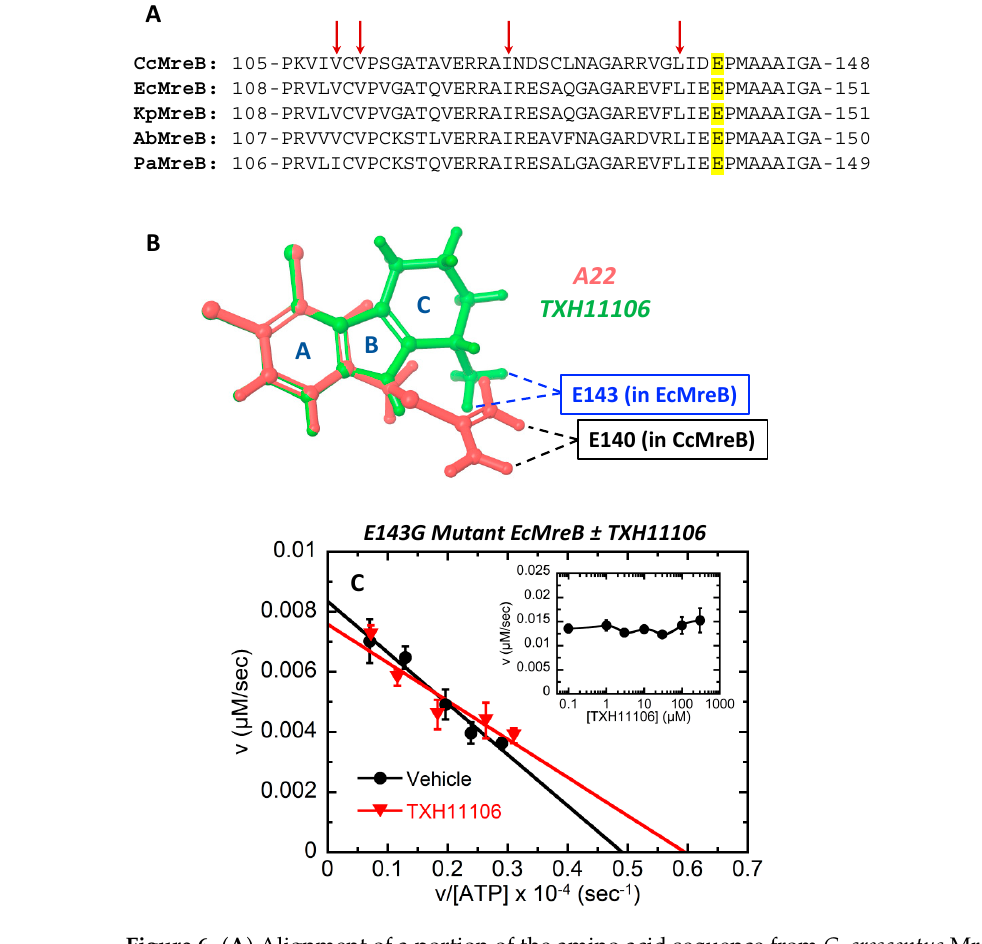
Figure 6. ( A ) Alignment of a portion of the amino acid sequence from C. crescentus MreB (CcMreB), E. coli MreB (EcMreB), K. pneumoniae MreB (KpMreB), A. baumannii MreB (AbMreB), and P. aeruginosa MreB (PaMreB). As revealed by the previously reported crystal structure of the CcMreB-A22 complex (PDB: 4CZG) [23], this portion of the MreB amino acid sequence includes residues that form key contacts with the inhibitor. The E140 residue in CcMreB (highlighted in yellow) that forms electrostatic and hydrogen bonding contacts with the amidine functionality of A22 is conserved in the EcMreB, KpMreB, AbMreB, and PaMreB proteins. The hydrophobic residues of CcMreB (indicated by the arrows) that form Van der Waals contacts with ring A of A22 are also conserved in the other four MreB proteins. ( B ) Overlay of the gas-phase models of A22 (red) and TXH11106 (green). The contacts observed between the E140 residue of CcMreB and the amidine substituent of A22 are depicted by the black dashed lines, with the proposed corresponding contacts between the E143 residue of EcMreB and the amino functionality on ring C of TXH11106 being depicted by the blue dashed lines. The gas-phase models were generated using the Jaguar application of the Schrodinger Maestro version 12.9.123 software package. Compound geometries were optimized in the functional B3LYP-D3 gas phase. ( C ) Eadie–Hofstee plots of the ATP-dependent catalytic activity of E143G mutant EcMreB in the presence of DMSO vehicle or 30 µM TXH11106. Each experimental data point represents an average of three replicates, with the indicated error bars reflecting the standard deviation from the mean. The solid lines represent linear fits of the experimental data points. The inset depicts the impact of increasing concentrations of TXH11106 on the velocity of the ATPase reaction of E143G mutant EcMreB. Each experimental data point represents an average of two replicates, with the indicated error bars reflecting the standard deviation from the mean.